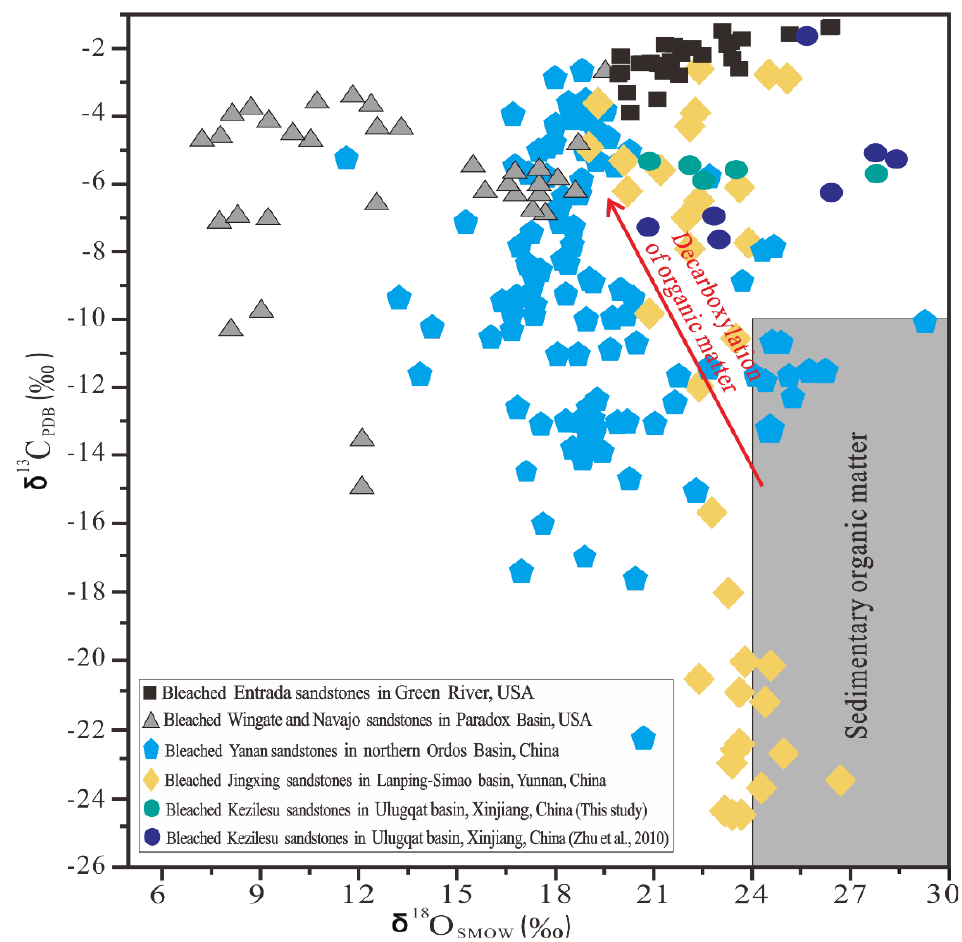
Figure 11. δ 18 O SMOW - δ 13 C PDB diagram of calcite in the bleached sandstone from the Uragen deposit and other red beds worldwide, including the Entrada sandstone in Green river, USA [38], the Wingate and Navajo sandstones in Paradox basin, USA [6,46,47], the Yanan sandstone in northern Ordos basin, China [40–42], the Jingxing sandstone in Lanping–Simao basin, China [43–45], and the Kezilesu sandstone in Ulugqat basin, China ([24] and this study).